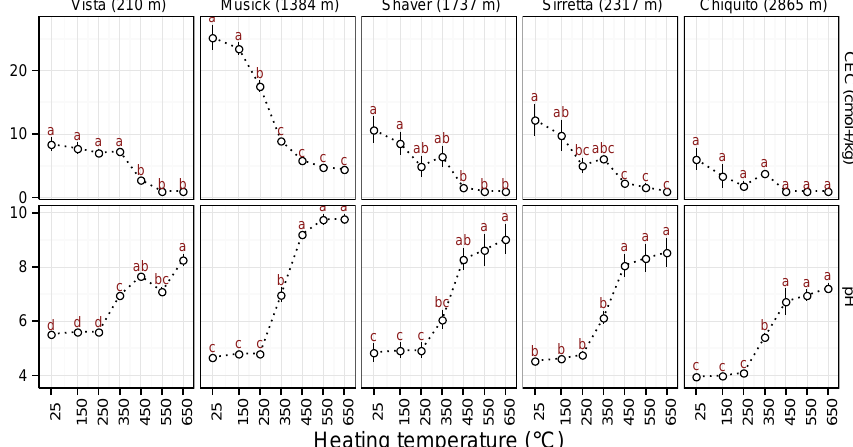
Figure 8. pH (geometric means) and cation exchange capacity (adjusted for mass loss) changes with increase in heating temperature. CEC values below the 2cmol c kg − 1 are assigned a value of 1 for plotting. Error bars represent standard error where n = 3. Different letters represent significantly different means ( p < 0.05) at each temperature after Tukey’s HSD